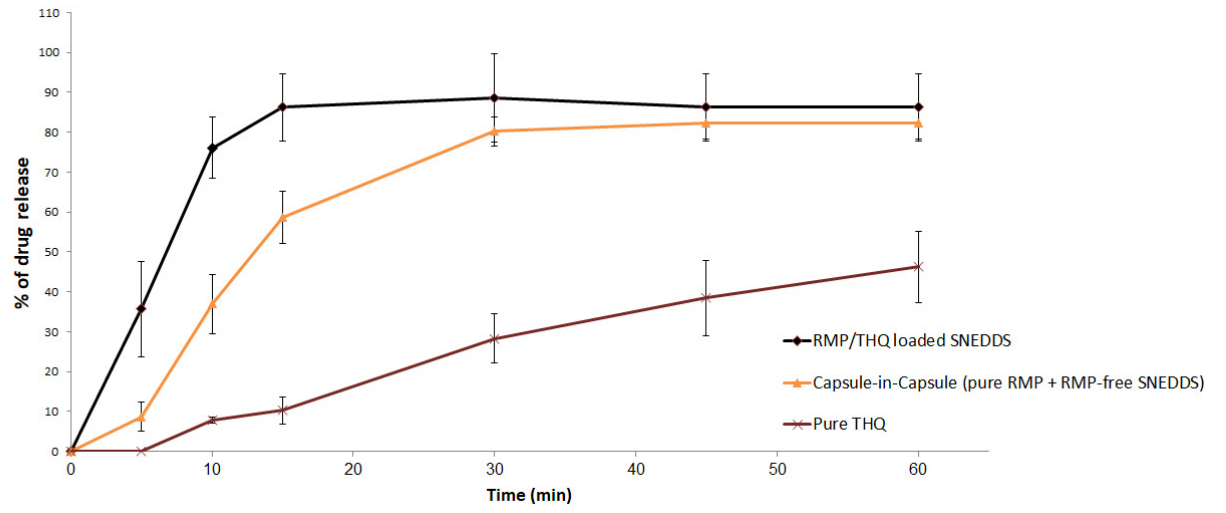
Figure 8. In vitro dissolution of THQ SNEDDS formulations at pH 1.2. Data are represented as the mean ± SD, n = 3.